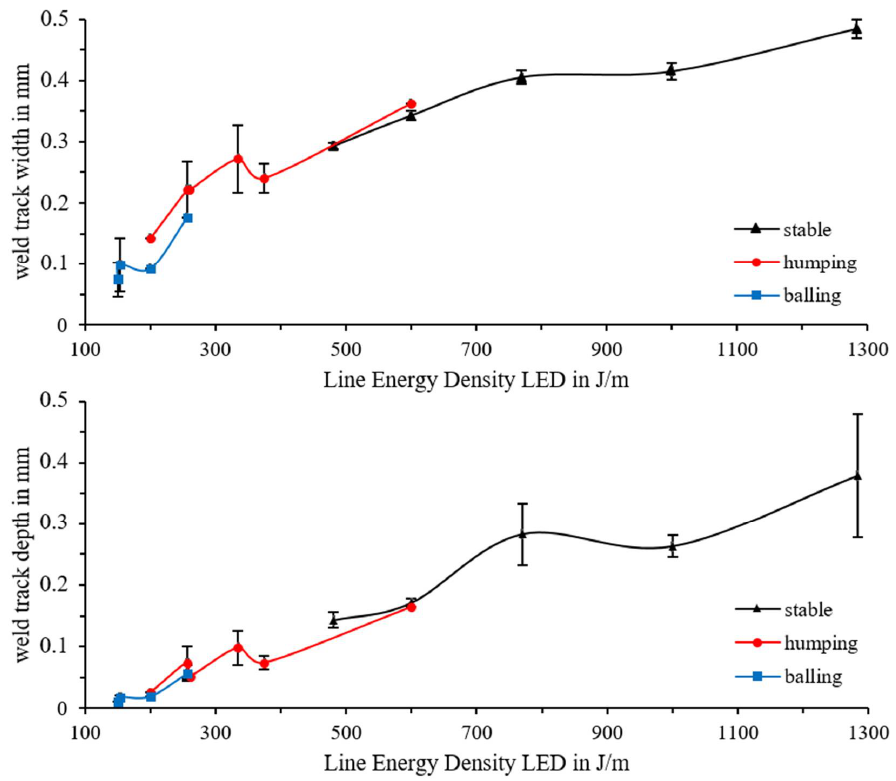
Figure 5. Weld track width and depth vs. scan velocity for two different values of laser power. Measurements of the weld track depth show similar results. Higher LEDs result in a higher weld track depth due to a deeper keyhole/melt pool depth. The rise in the weld track depth can be explained by the keyhole effect and rising vapor depression depth, as Martin et al. have shown [18]. The amount of process-pore occurrence also increases due tributed to the formation of the process pores. Due to the repeated contracting of the key- hole, the melt pool depth reduces before the keyhole is fully formed again, as described